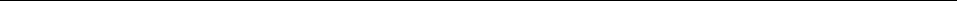
Table 4. Relationships between otolith width (OW), total fish length (FL) and fish weight (FW) for herring and sprat collected from ICES subdivision 25, 27 and 29. N equals the number of indi- viduals of each species in the sample on which the equations are based upon. The correlations between otolith width in mm and fish length in mm and fish weight in gram are described by the equations FL=a+b · OW and FL=c · OW d ,